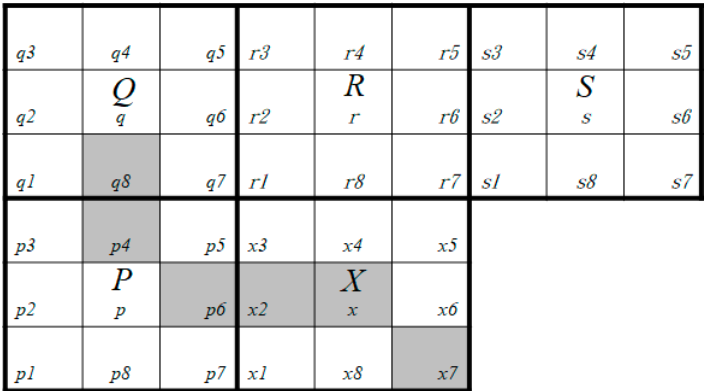
Figure 11. Cross-block texture extension diagram.